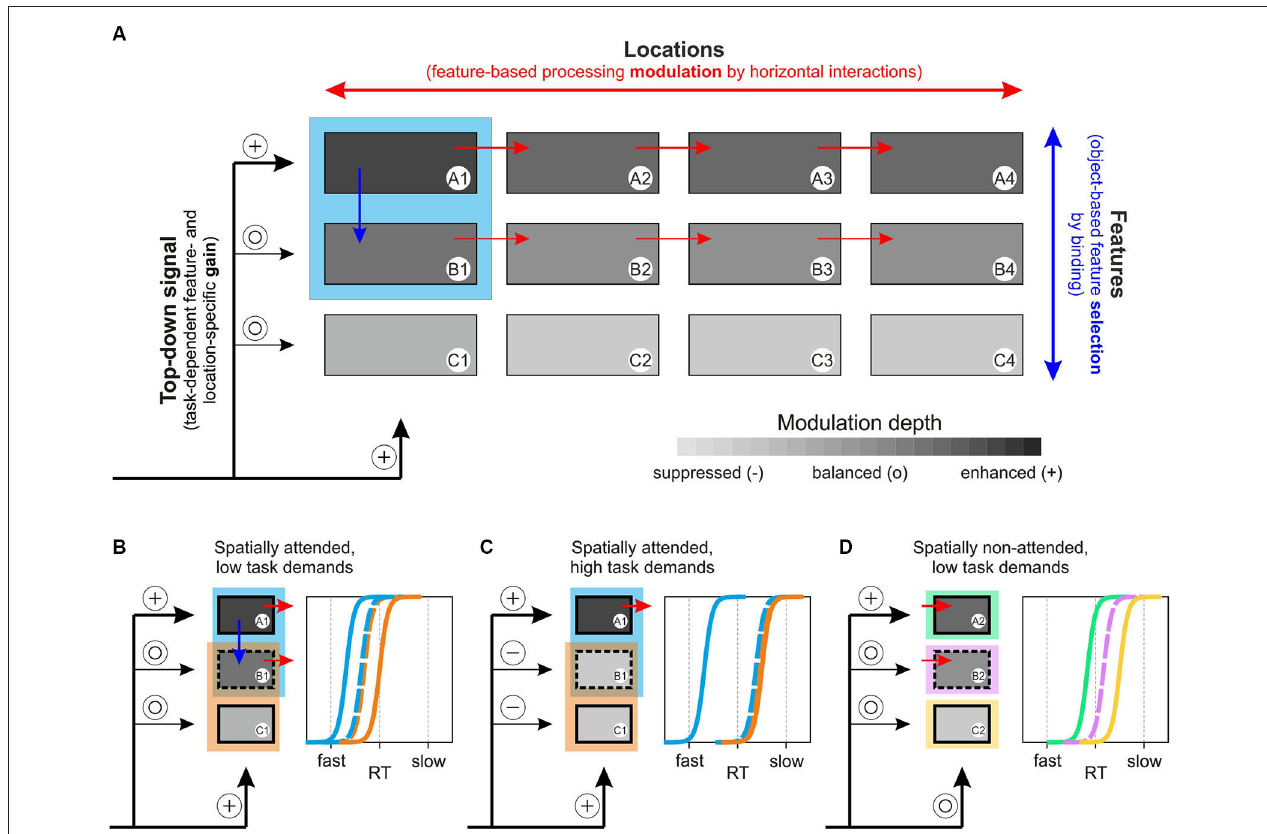
(that may be attenuated if task-dependent top-down gain is set to induce suppression of task-irrelevant channels, cf. Figure 6C ). Subsequently, features that are selected due to either task instructions (feature A) or binding dynamics (feature B) receive a global processing enhancement, mediated by horizontal interactions within feature channels (red arrows). (B) Predictions of RT distributions for two spatially overlapping objects at the spatial focus of attention, consisting of one feature that is unique to each of the objects and another that is shared by both objects, under low and (C) high task demands. (D) Predictions of RT distributions for three distant objects, consisting of either feature A, B, or C under stimulation conditions as those shown in Figure 6B . See main text for further